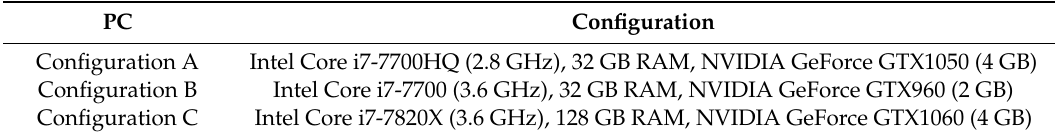
Table 1. Accuracy of the scanners involved in the comparison. Table 2. Personal computer (PC) configuration for performance